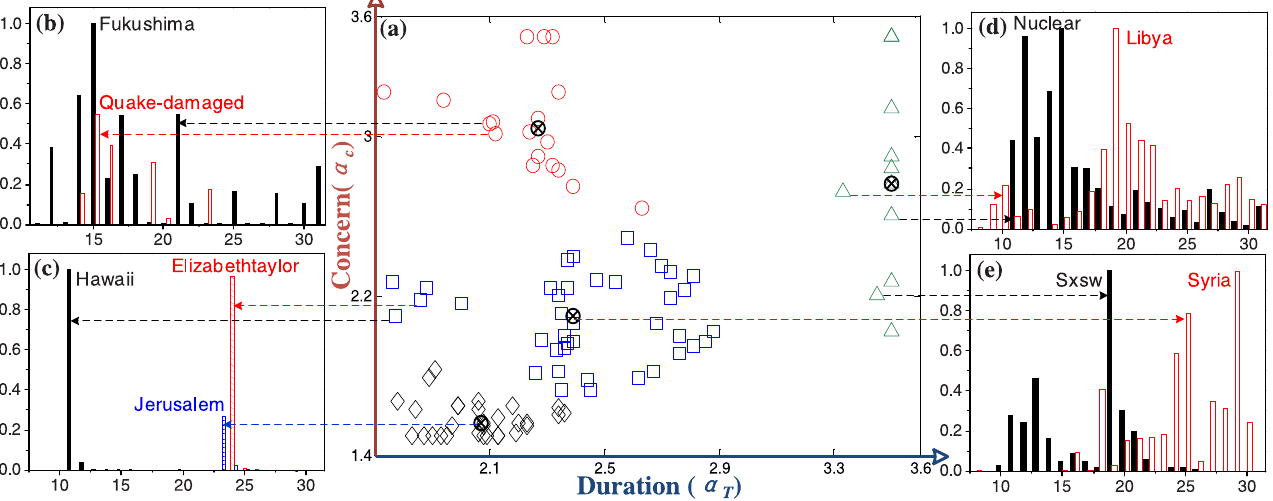
Fig 2. The illustration of classification in the CD space based on the ranking values of human concerns and durations ( k = 4 in KM algorithm). Some events, as shown in (c) and (e), are categorized into groups even if they have similar shapes of time series. Through comparing the temporal dynamic of collective online behaviors from Twitter, we find that our method can overcome the effect of multiple peaks in the curve, and provide more precise classification even if two events have similar shape of time series data.